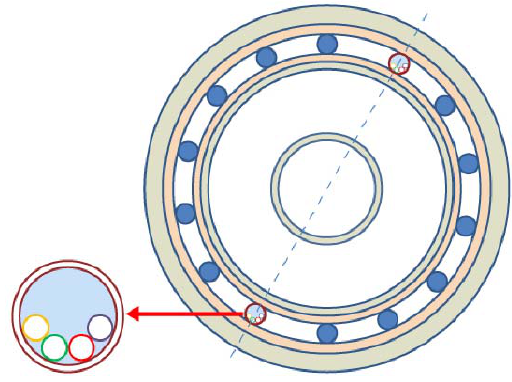
Figure 3. Cross-section of the optical fiber composite power cable